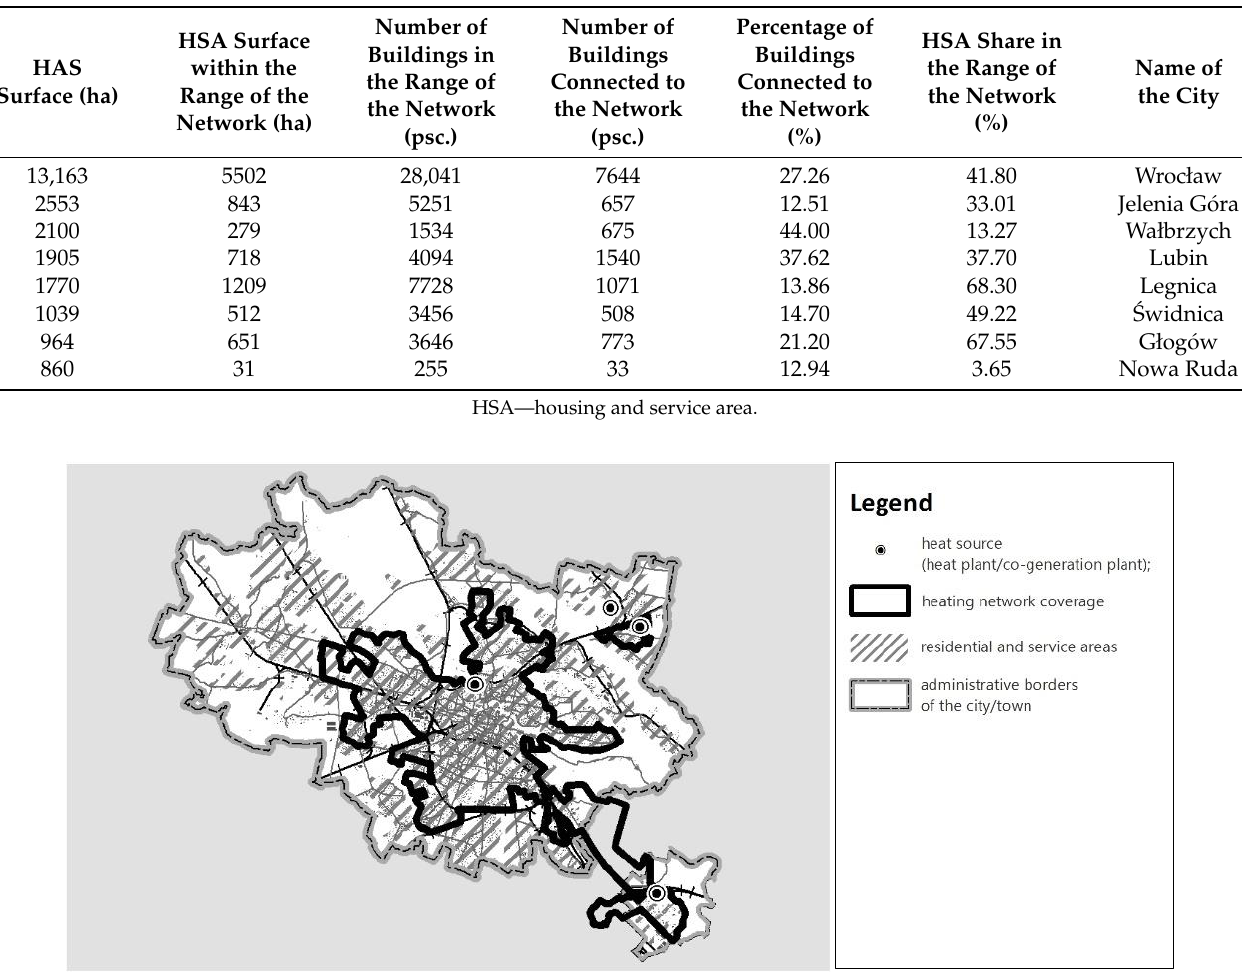
Figure 1. Areas intended for housing and service development, and the range of the district heating network in Wrocław and the neighbouring town of Siechnice. * HSAs—housing and service areas.